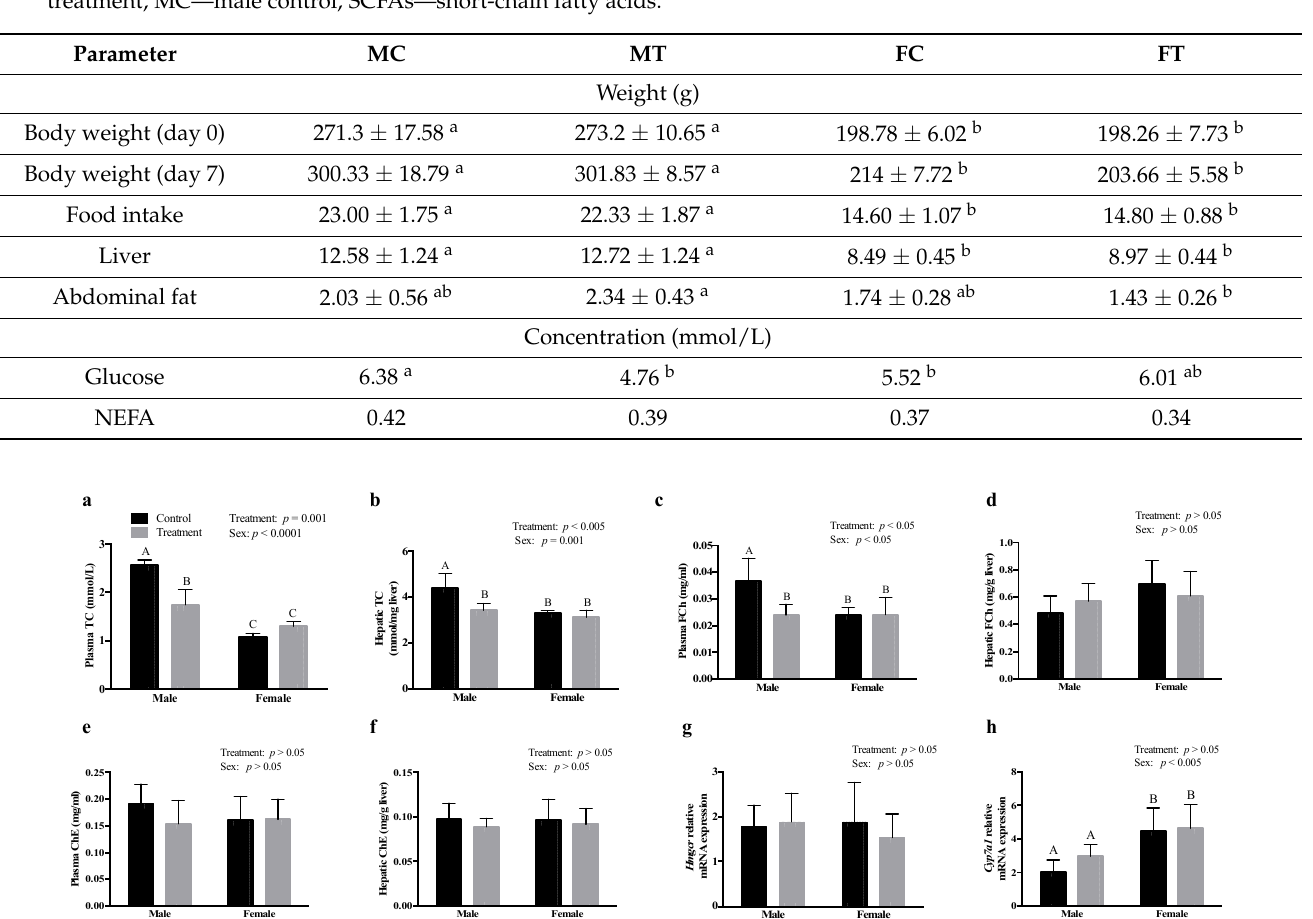
Table 1. Effect of short-chain fatty acids on body weight, organ weight (relative to body weight), glucose, and non-esterified fatty acid (NEFA) concentrations. Data were analyzed using two-way ANOVA followed by Tukey’s post hoc test. Values are presented as mean ± SD. Different superscripts indicate significant difference amongst groups; only the male treatment (MT) group showed decrease in glucose levels. p < 0.05 was considered significant ( n = 6). FC—female control, FT—female treatment, MC—male control, SCFAs—short-chain fatty acids.